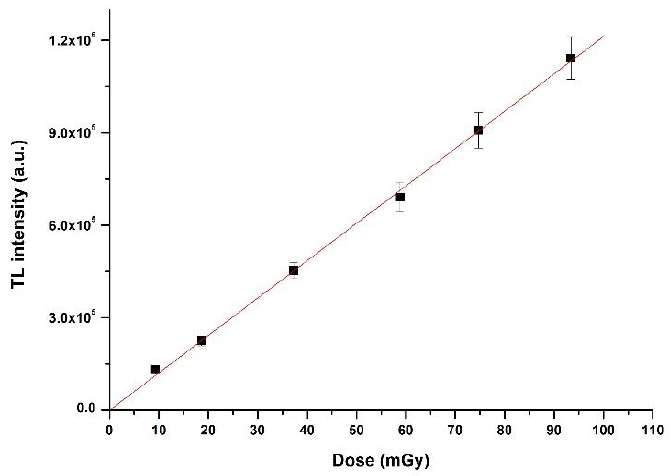
Figure 4. Calibration curve for TLD 100H.